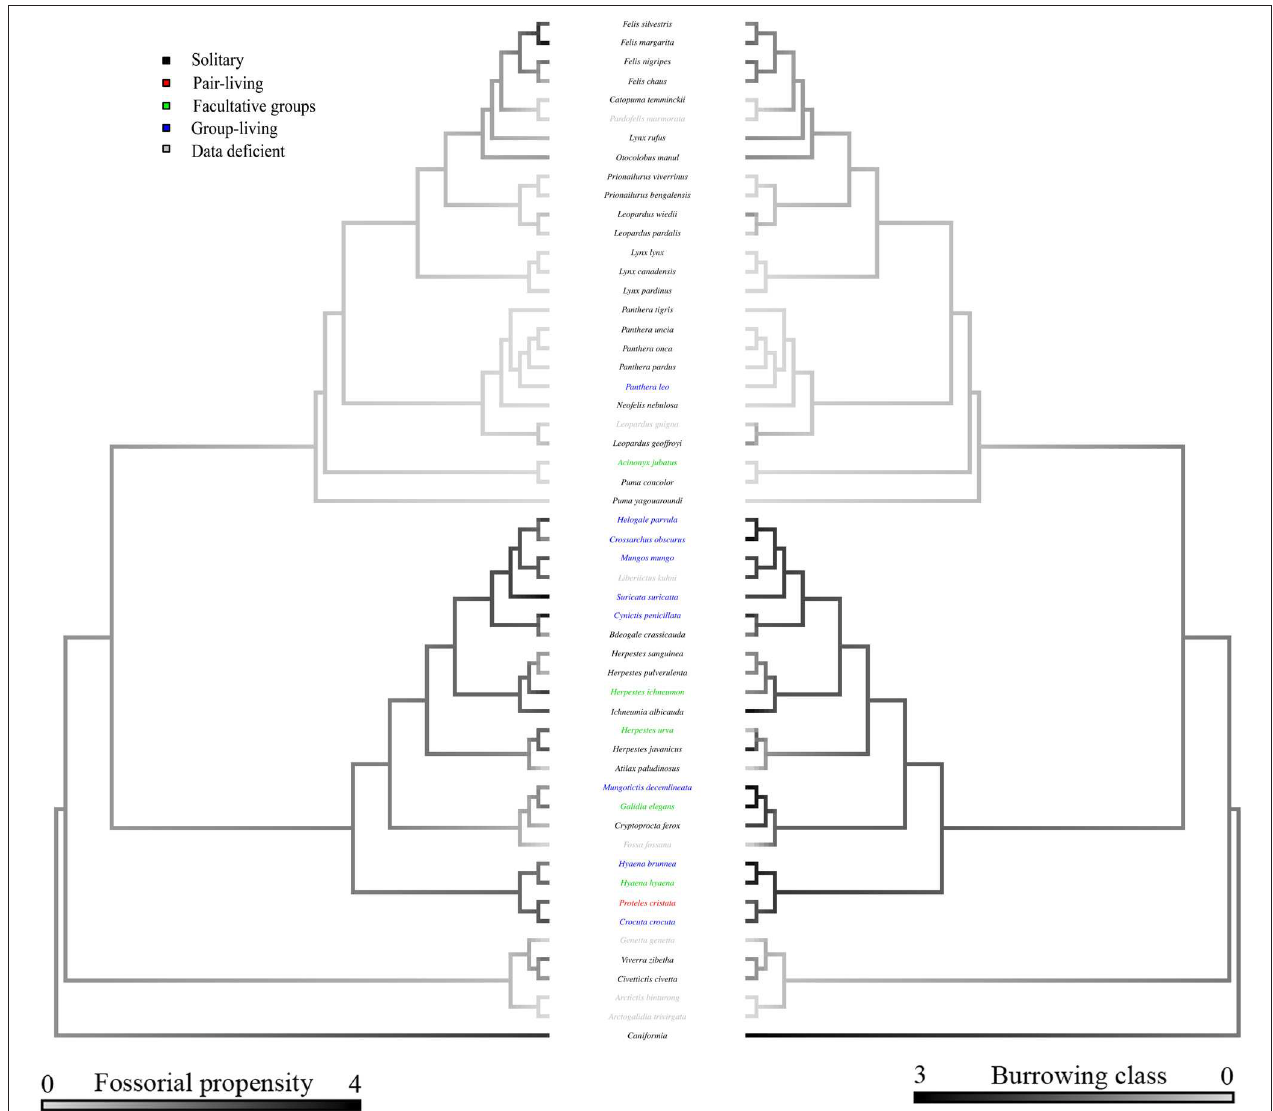
FIGURE 3 | Consensus tree of the Feliformia based on phylogenetic relationships from Agnarsson et al. (2010). For clarity, the Caniformia are collapsed. Shading of the left hand branches depicts fossorial propensity scaled from wholly epigean, to wholly fossorial. Shading of the right hand branch depicts burrowing class scaled from no burrow use, to primary excavators. Coloration of species labels denotes group-living propensity (see Figure 2 ). Data deficient species are listed in